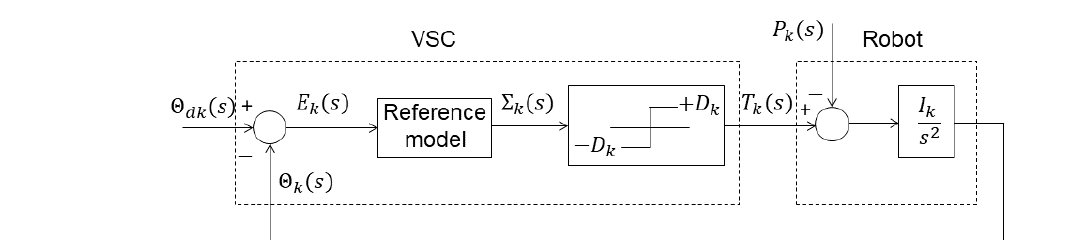
Figure 1. Block diagram of a VSC-controlled robot